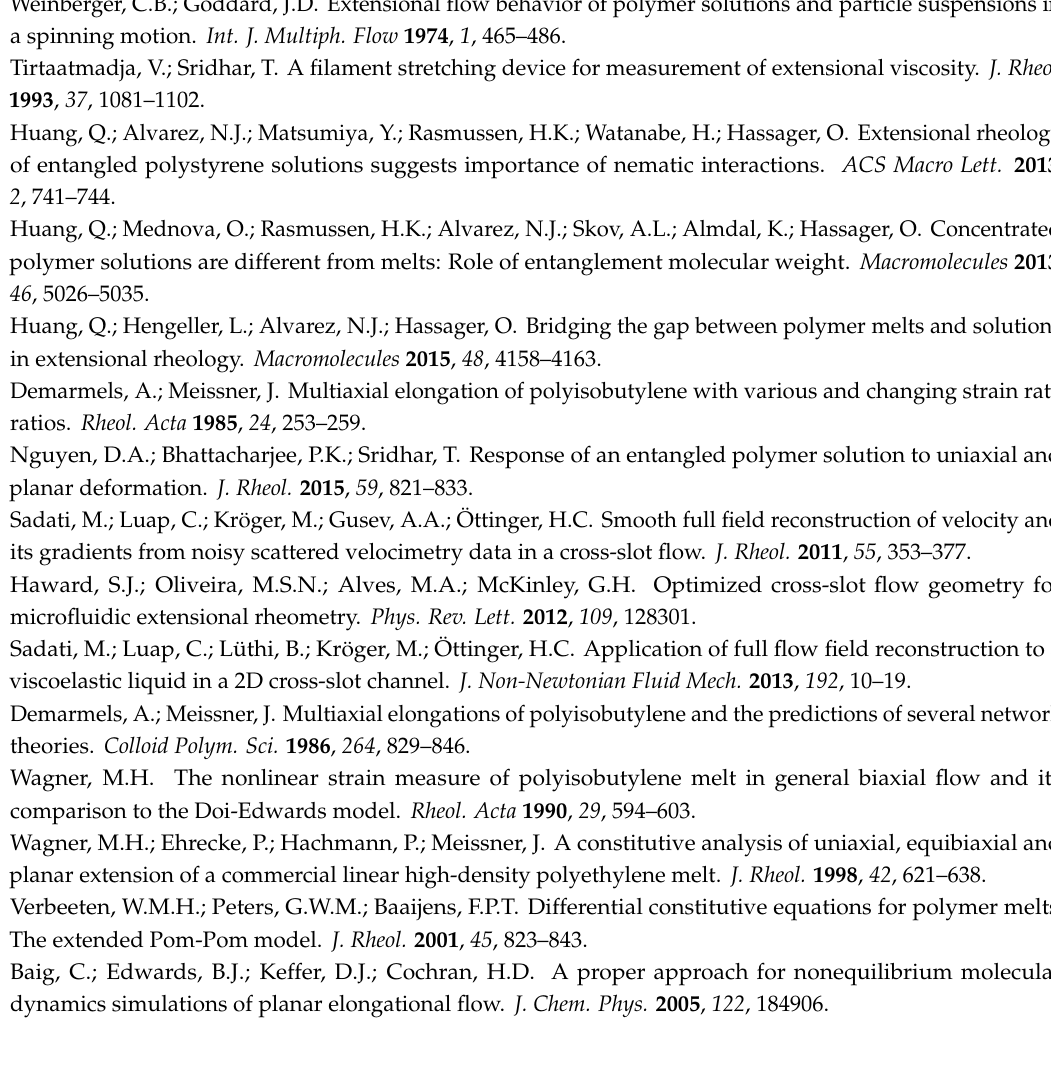
Figure S1: Steady-state first planar viscosity, Figure S2: Steady-state second planar viscosity, Figure S3: Transient first planar viscosity, Figure S4: Transient second planar